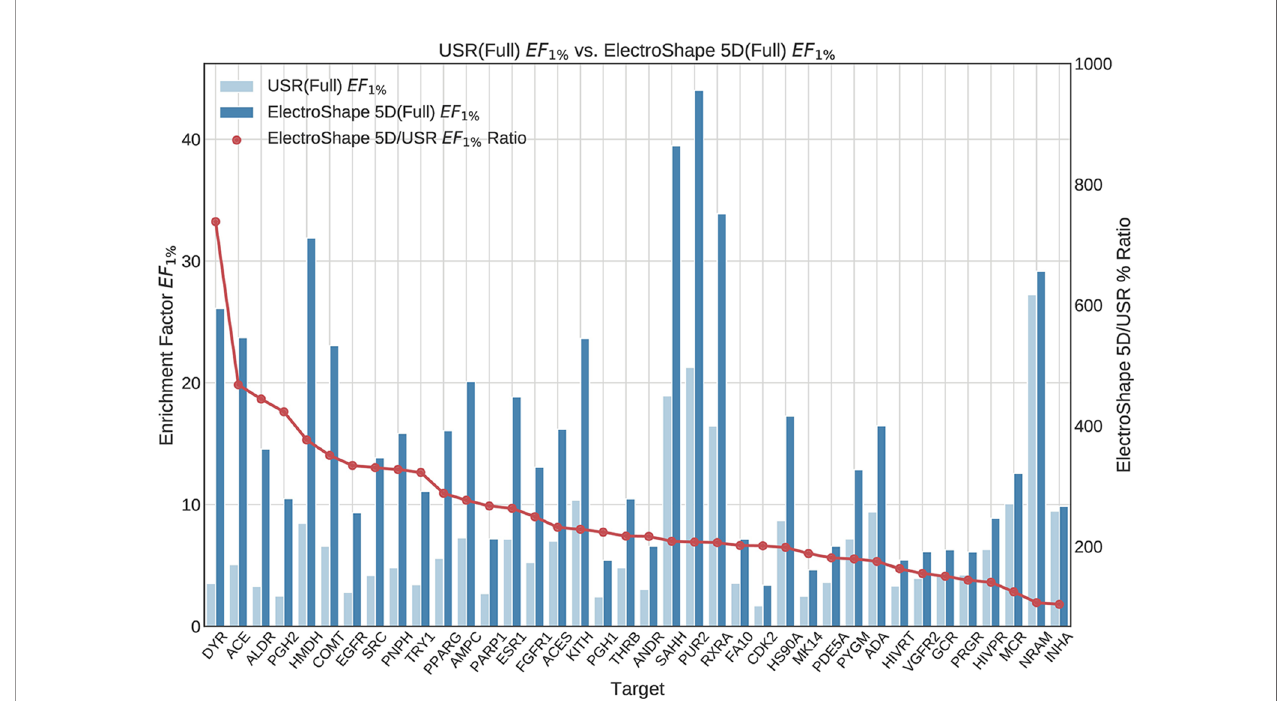
FIGURE 2 | Comparison of Enrichment Factor at 1% ( EF 1% ) obtained by USR with that obtained by ElectroShape 5D using full conformer models. Also plotted is the percentage ratio of the Enrichment Factor score of ElectroShape 5D compared to Ultrafast Shape Recognition (USR). Mean ratio = 253% ± 122%, max = 738%, min =